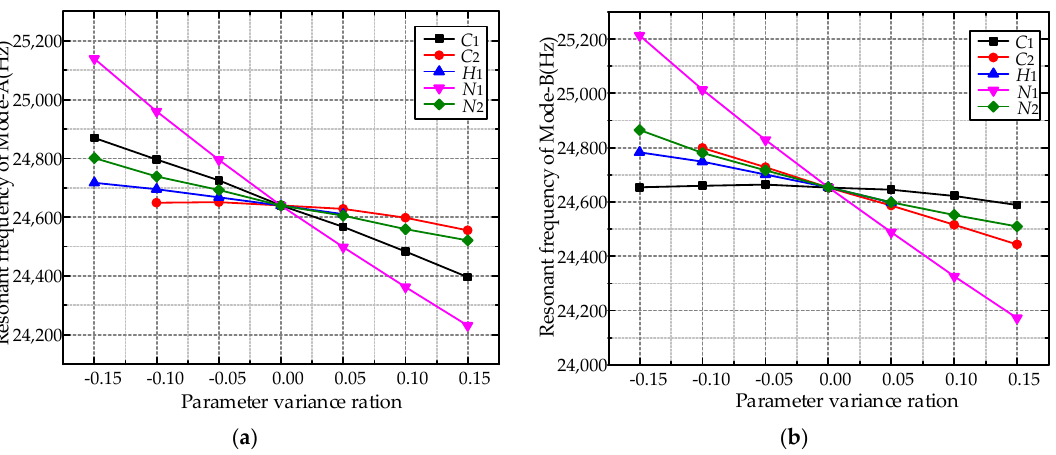
Figure 5. Sensitivity curves of modal frequencies: ( a ) Sensitivity curves of Mode A; ( b ) Sensitivity curves of Mode B.